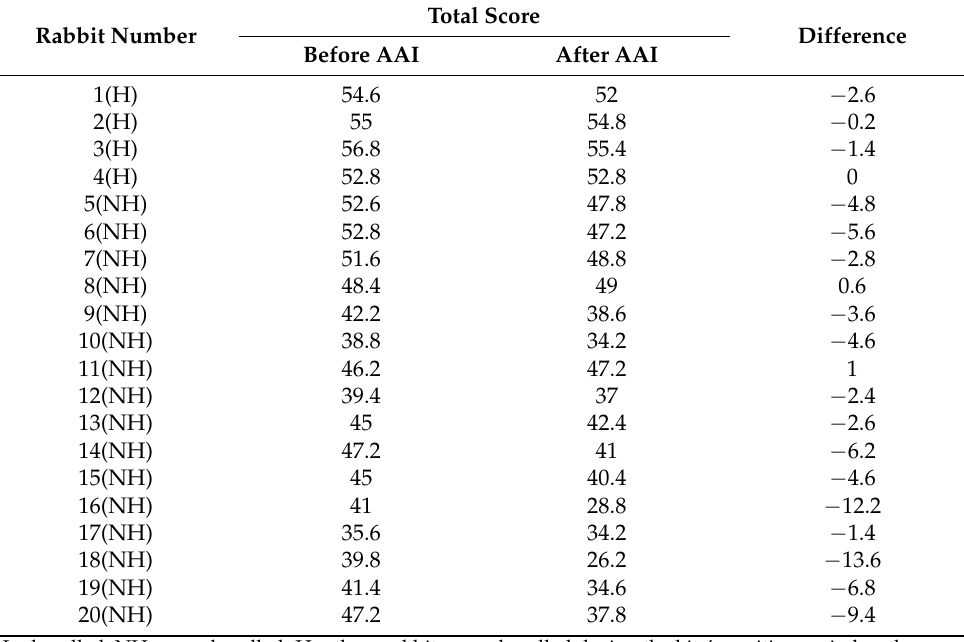
Table 2. The total scores of the 20 rabbits before and after AAI.